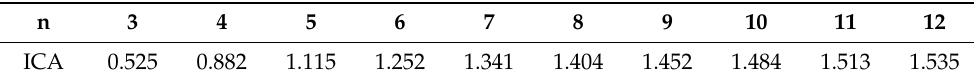
Table 3. Random consistency values according to the rank of the matrix. n